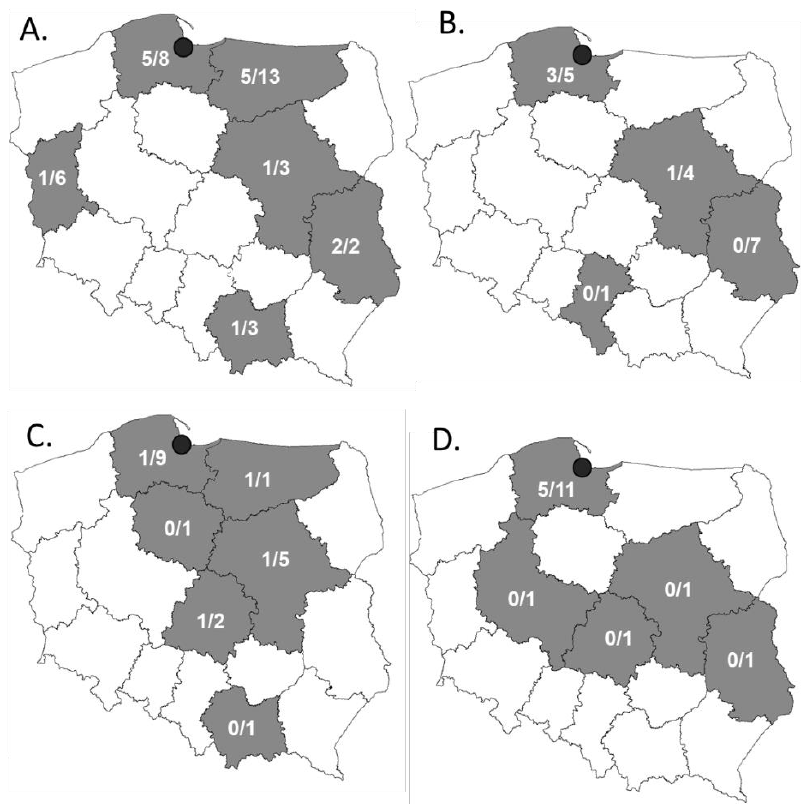
Figure 1. Localization of plants processing meat, from which the meat was sampled in Gdansk mar- kets (black dot). A. Turkey ( n = 35); B. chicken ( n = 17); C. pork ( n = 19); D. beef (15). In case of 11 samples of unknown producer, they were assigned to Pomorskie voivodeship. Table 1. Overview of the meat samples obtained from 5 markets in Gdansk, Poland, during 2020.